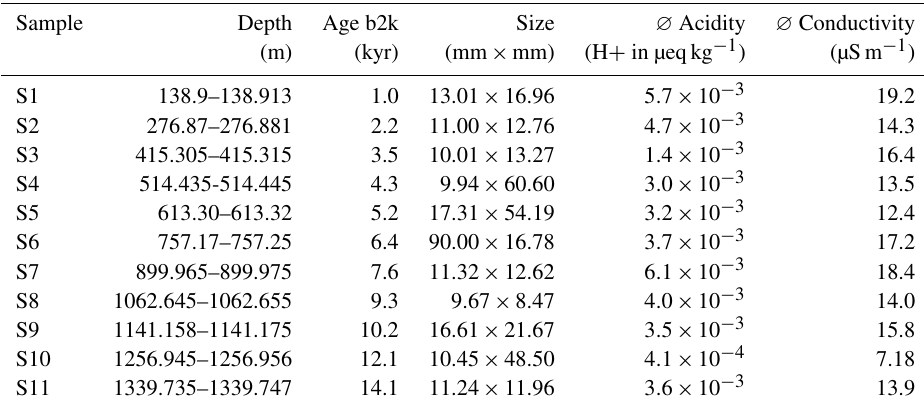
Table 1. Properties of the samples analysed with Raman spectroscopy. Acidity data from Mojtabavi et al. (2020b) and conductivity data from Mojtabavi et al.